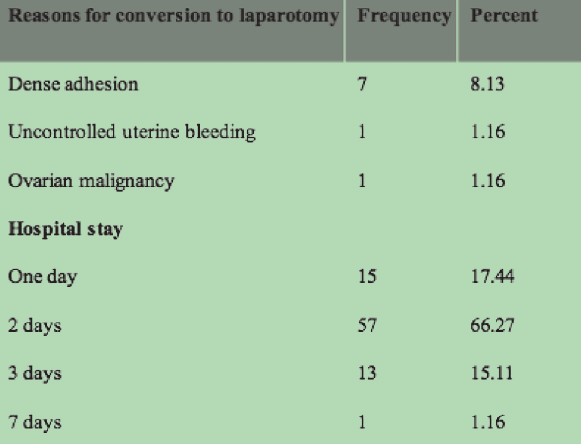
Table 4: Reasons for conversion to laparotomy